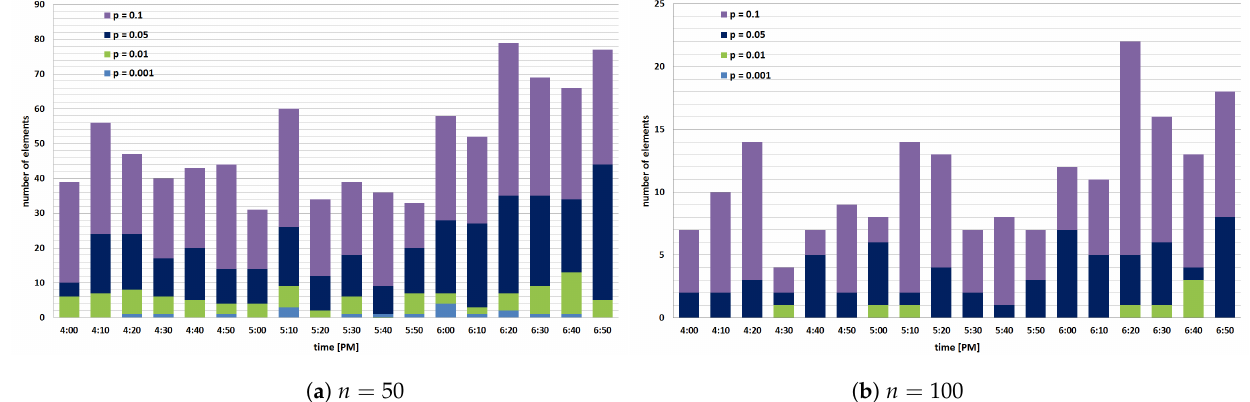
Figure 5. The influence of parameter n on the number of lost elements.